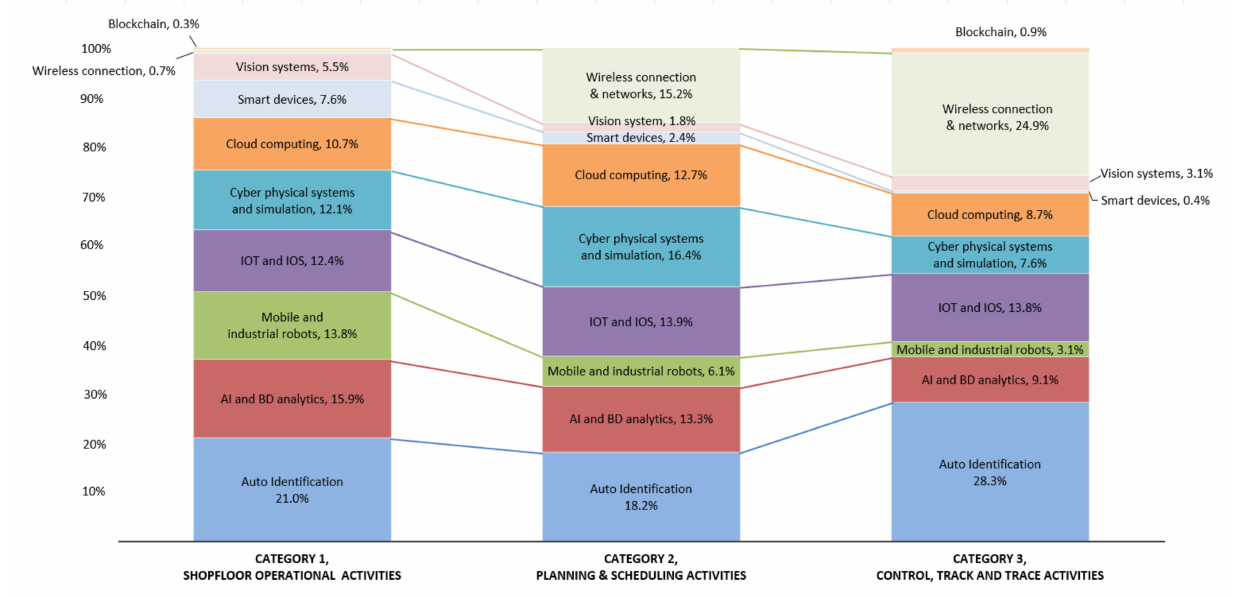
Figure 4. Share of the identified technologies supporting production logistics (PL)